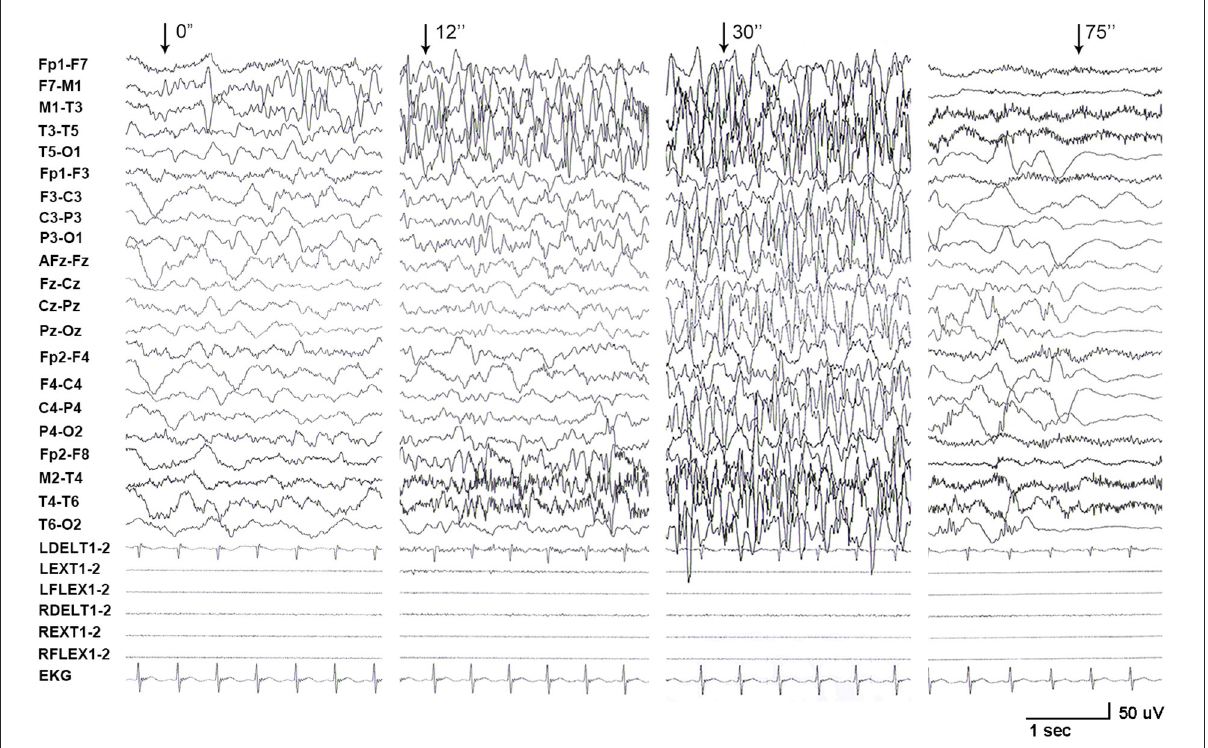
FIGURE1 EEG recordings from patient with PRRT2 variants. A long-term video electroencephalogram recorded a seizure that started with spikes originating from the left frontal lobe and gradually generalized, lasting for 75s, followed by electrical